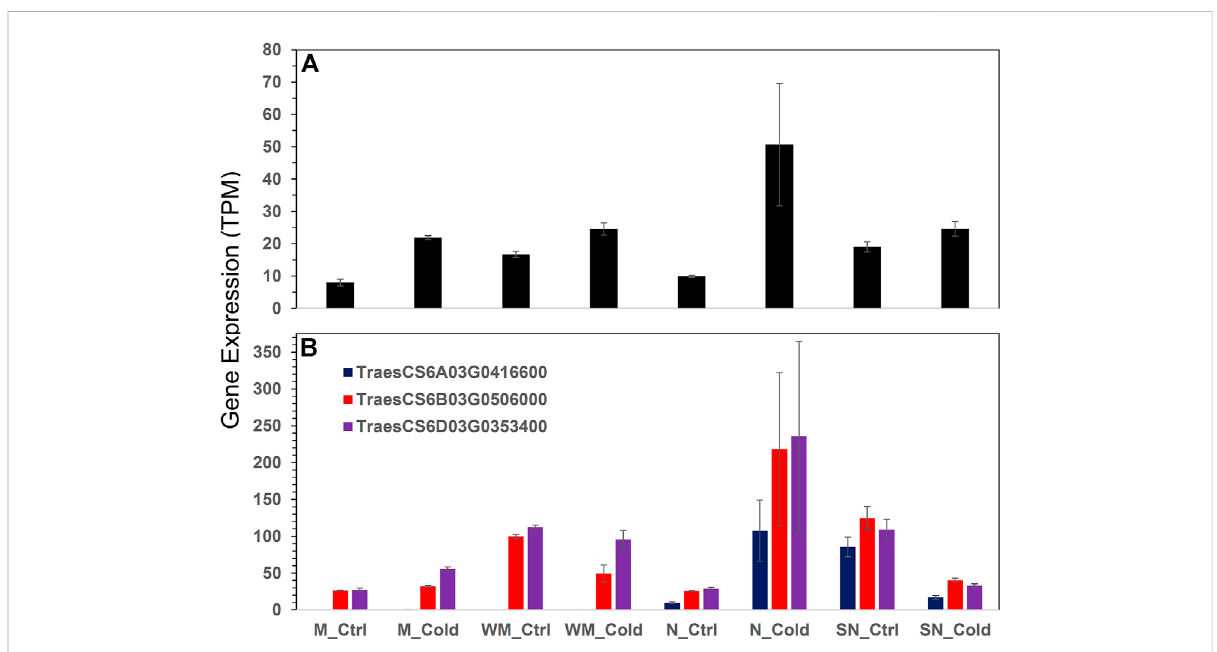
FIGURE 3 Expression of peroxiredoxins across all samples. (A) peroxiredoxin-2F, mitochondrial isoform X1, (B) peroxiredoxin-2E-2, chloroplastic-like. Error bars are one standard error of the mean of three replicates.